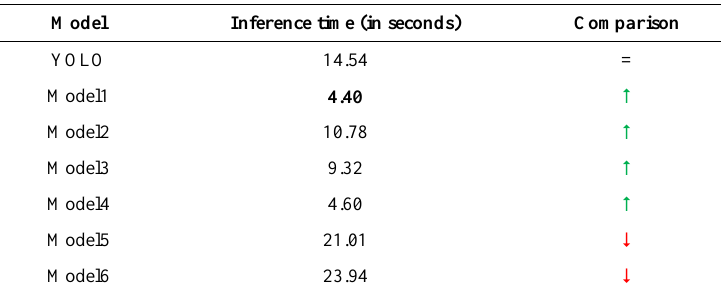
Table 3. Inference times for the different